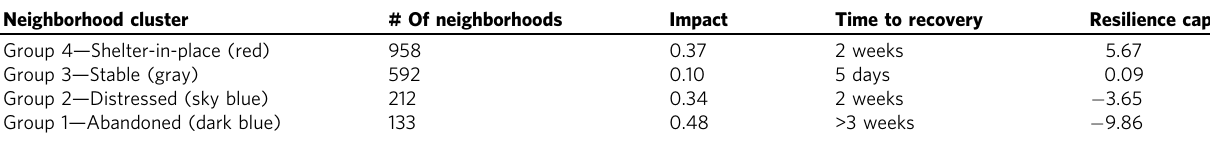
Table 1 Measurement of mean impact, time to recovery, and resilience capacity for each